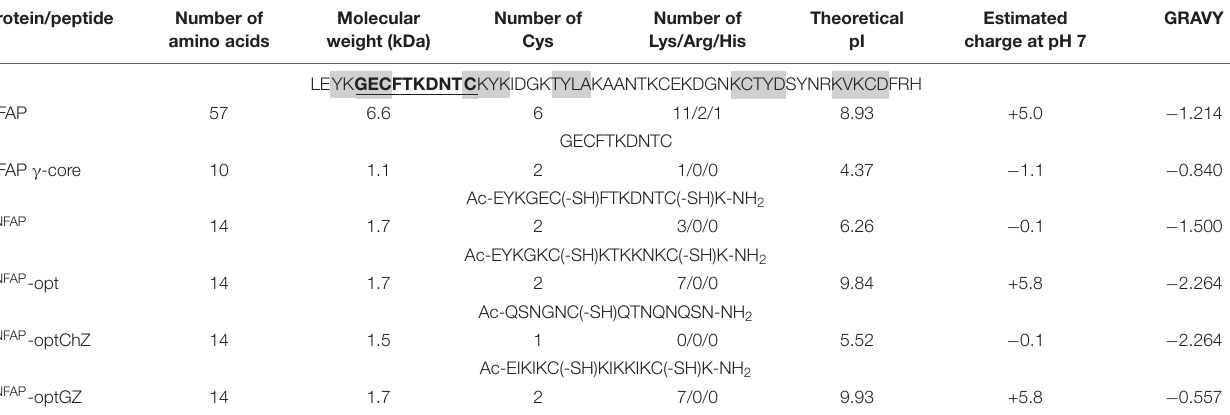
TABLE 2 | Amino acid sequence and in silico predicted physicochemical properties of mature Neosartorya fischeri antifungal protein (NFAP) and peptide derivatives.